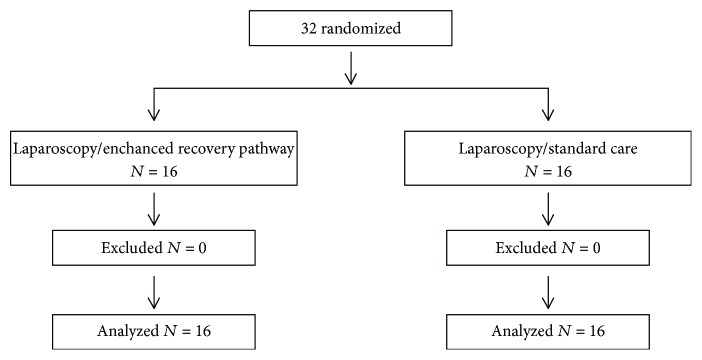
Study flow chart.